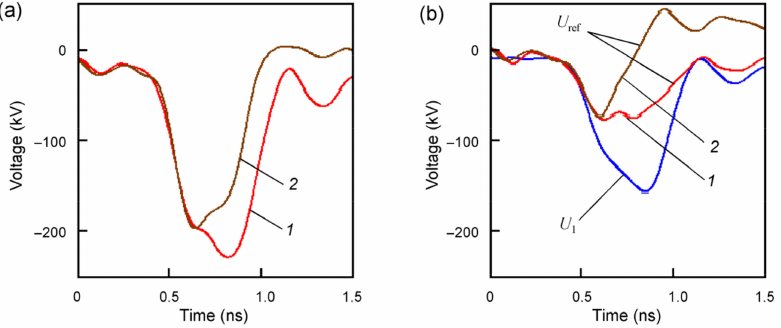
Figure 10. ( a ) The cathode voltage pulses registered using the DTDR method. ( b ) Supply pulse and the cathode reflections, time-aligned accounting for the delay τ 1 . Pressure: 1—3 × 10 − 2 Torr; 2—3 Torr. Other parameters: graphite cathode; D = 10 mm; B = 2.1